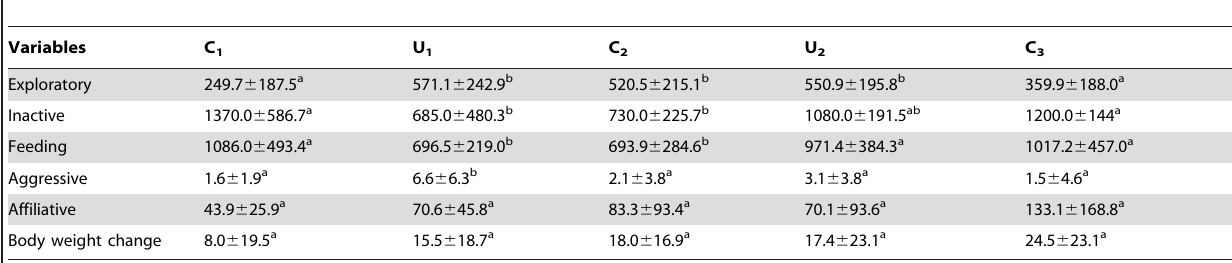
Table 1. Mean 6 SD of the time (s) the white-lipped peccaries spent on exploratory, inactive, feeding, aggressive, and affiliative behavioral patterns plus the body weight change (g/day) during the experimental phases (C 1 U 1 C 2 U 2 C 3 , C: control and U: